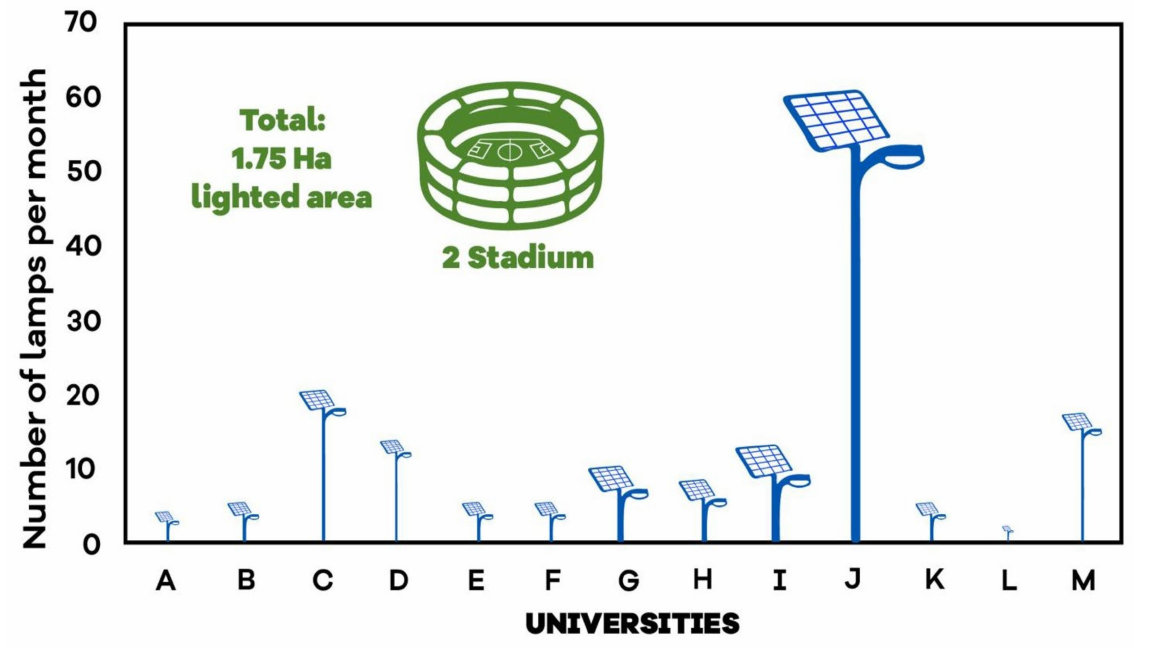
Figure 7. Projection of acquisition of solar systems for